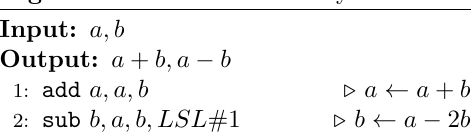
Algorithm 9 Radix-2 butterfly. Algorithm 10 Negative radix-2 butterfly.